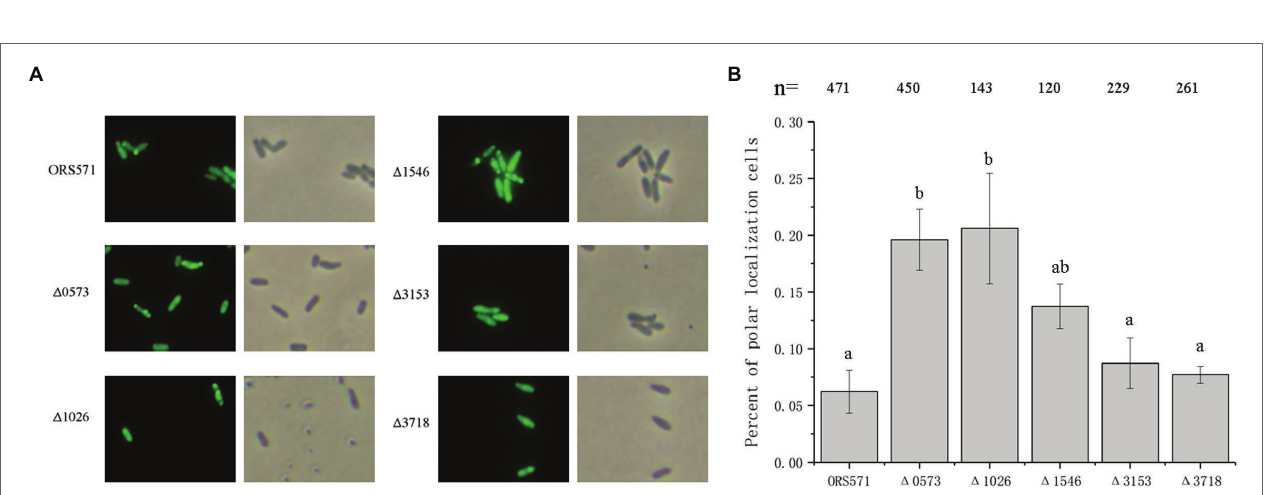
FIGURE 6 | Effect of soluble receptor on the localization of CheZ. (A) Representative images of CheZ localization observed in five intracellular receptor single mutants ( Δ azc_0573 , Δ azc_1026 , Δ azc_1546 , Δ azc_3153 , and Δ azc_3718 ). (B) Quantification of cells rations with polar localization of CheZ in different intracellular single receptor mutants. Values are means ± SDs from at least three independent experiments. The same letter above the bars indicates no significant difference at p < 0.05 by one-way ANOVA with Tukey’s multiple-comparison